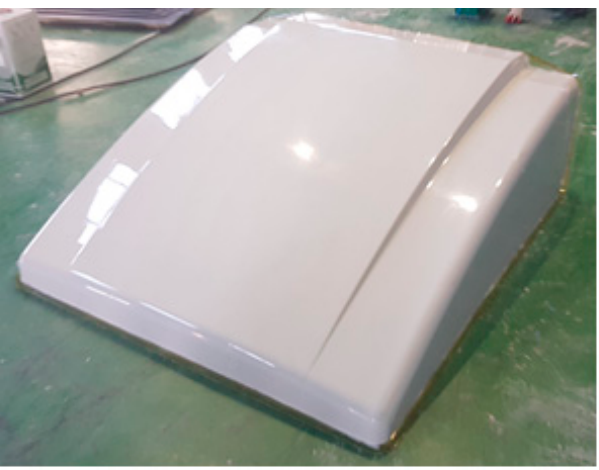
Figure 15. The manufactured fairing.